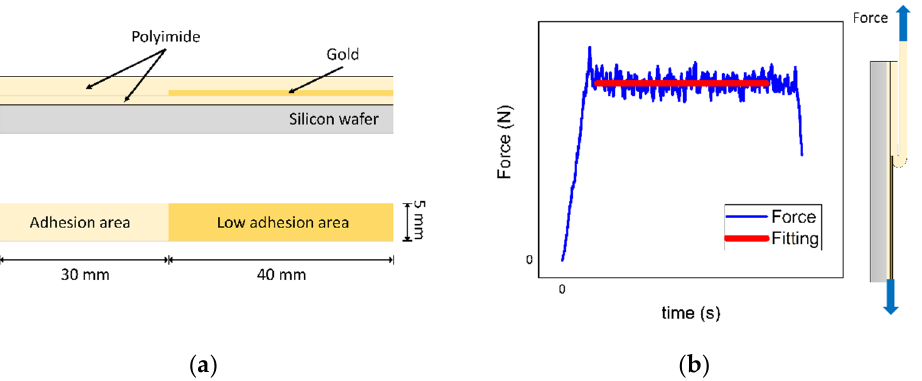
Figure 1. Peel test for adhesion between two PI films using Gold as a peel start: ( a ) Schematic view of the fabricated sample; ( b ) Method for computing the peel force, the lower PI film is fixed and the upper one is pulled up.